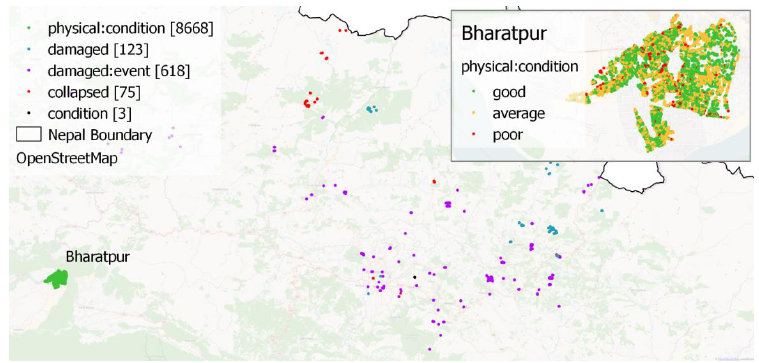
Figure 7. Map showing the location of building features in Nepal possessing a condition attribute.